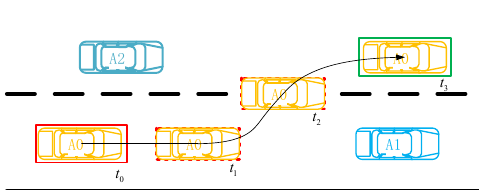
Figure 1. Schematic diagram of the vehicle lane-changing